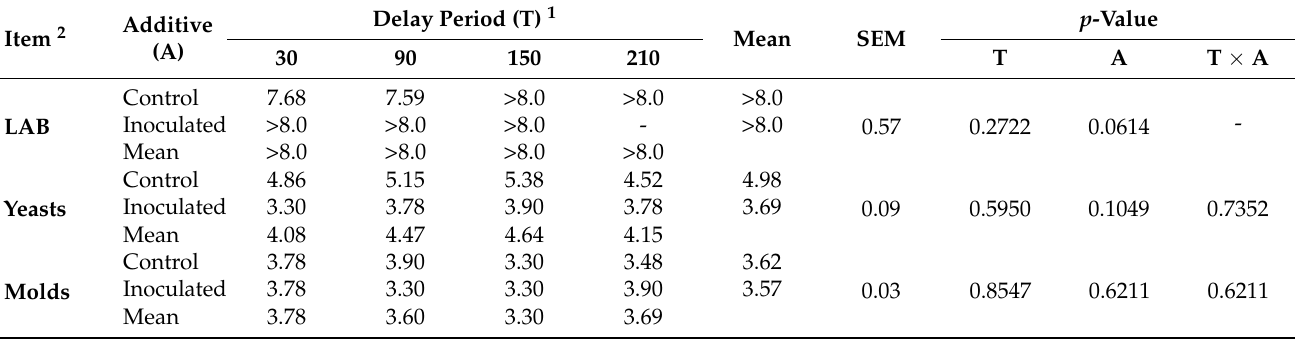
Table 3. Microbial counts of